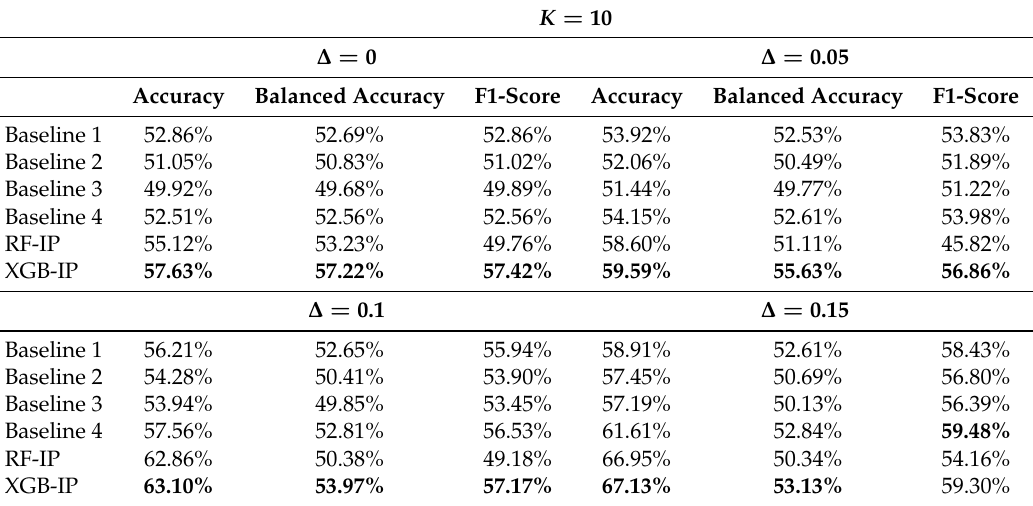
Table 5. Results of the experiments for K = 10 (best values are highlighted in